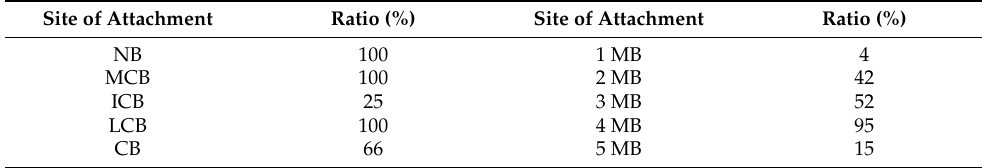
Table 1. Site of tibialis posterior attachment and